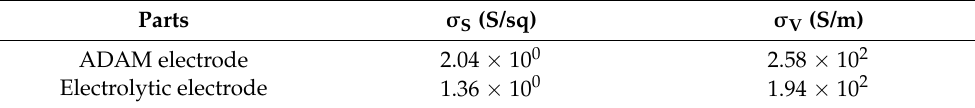
Figure 6. Summary workflow of the methodology applied. Table 7. Electrical conductivity of the